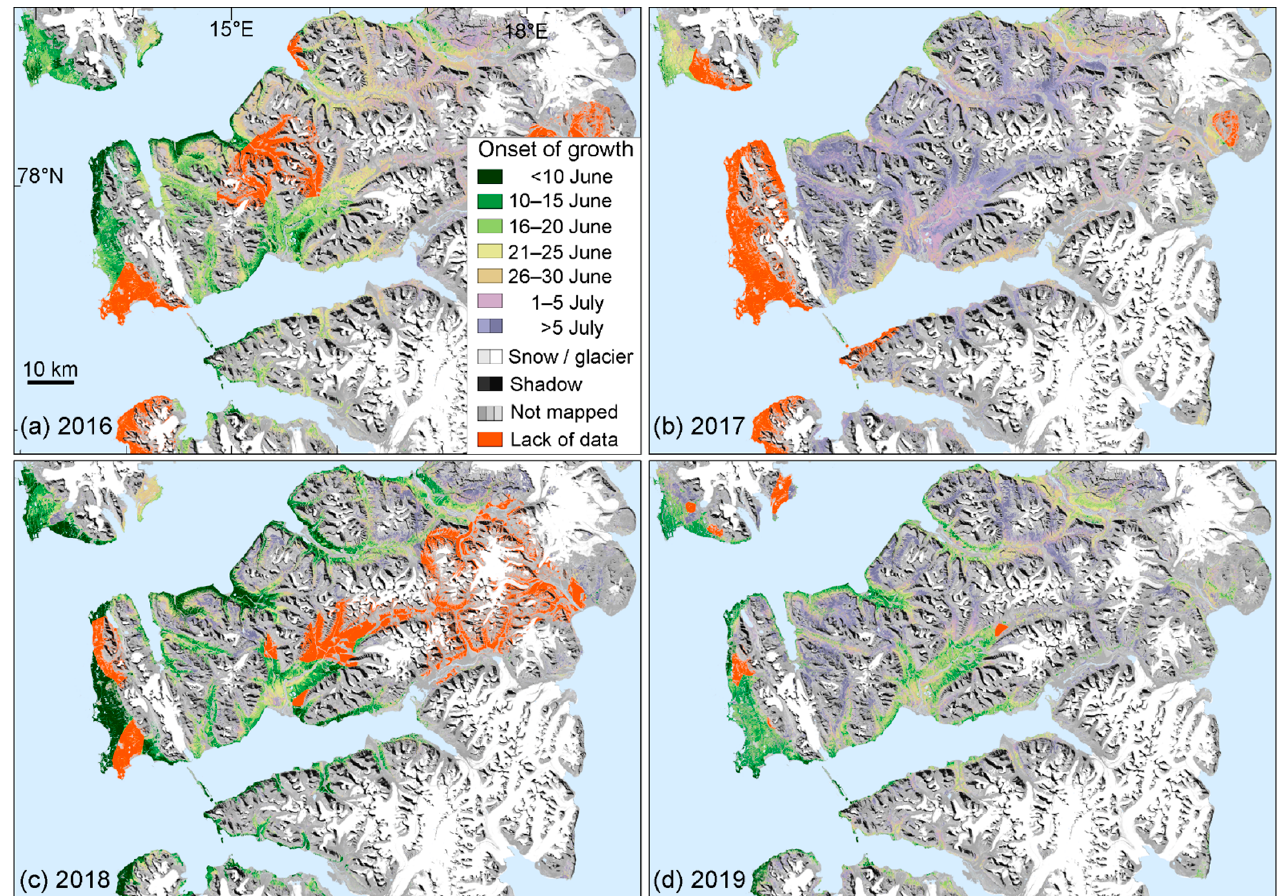
Figure 6. Central Svalbard. Onset of growth: ( a ) 2016; ( b ) 2017; ( c ) 2018; ( d ) 2019.